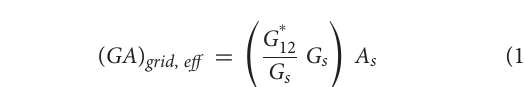
FIGURE 7 | Uniaxial compression test (A) and shear test (B) schemes on the RVE model.